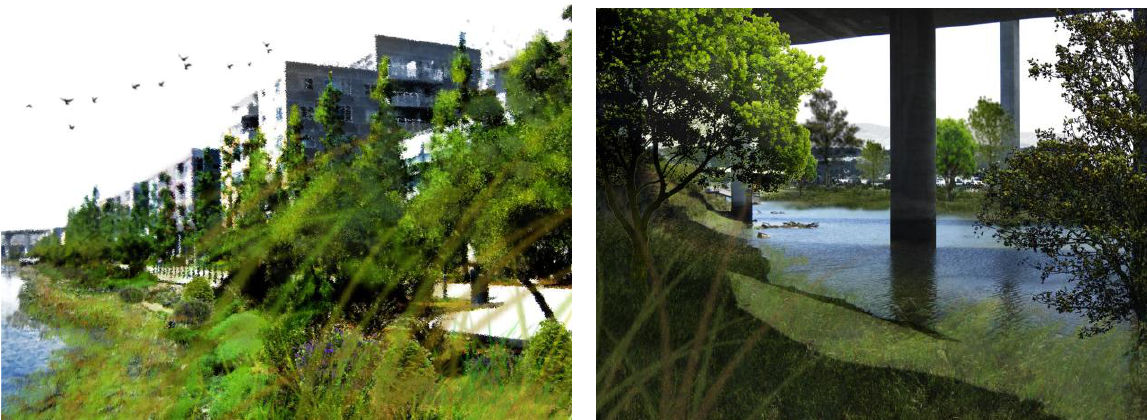
Figure 5. Alternative visions for a resilient Oakland. Images courtesy of Tyler Van Pelt, UCD BSLA